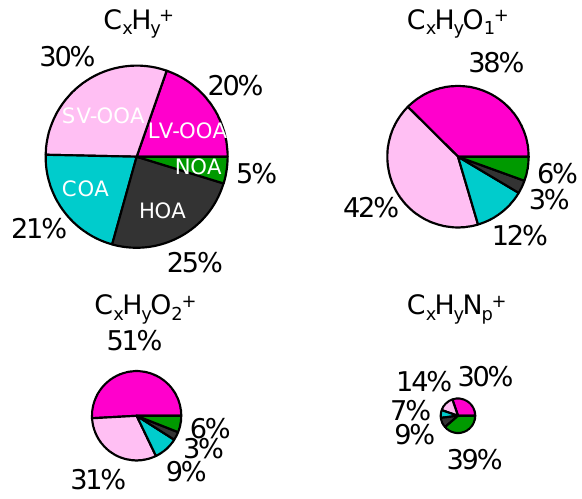
Fig. 10. Average contribution of OA components to four ions cate- gories, i.e., C x H + y , C x H y O + , C x H y O + , and C x H y N + p , for the en- 1 2 tire study. The area of each pie is scaled to be proportional to the mass concentration of the corresponding